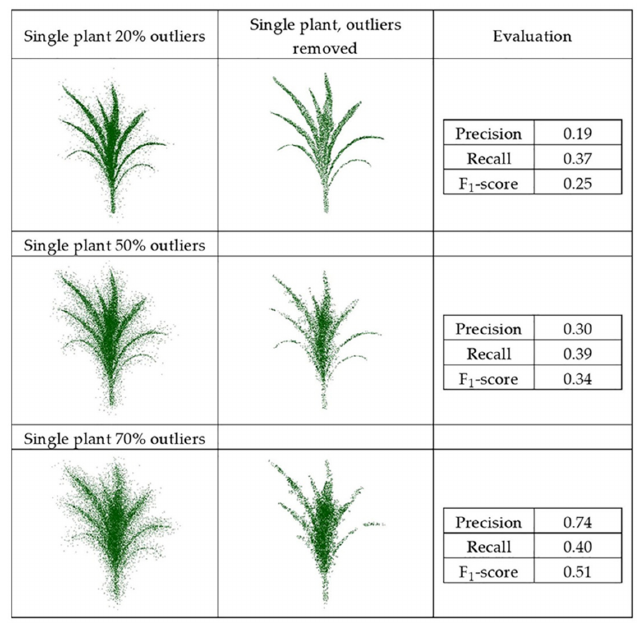
Figure 11. Geometric method outlier removal for a synthetic point cloud.